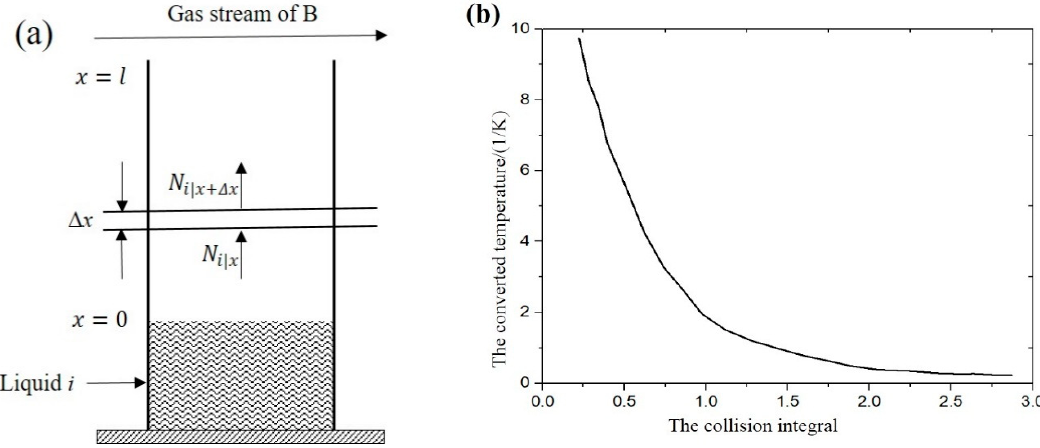
Figure 2. Element vaporization kinetics calculation [28]: ( a ) element vaporization in static gas atmosphere; ( b ) the functional between collision integral and converted temperature.